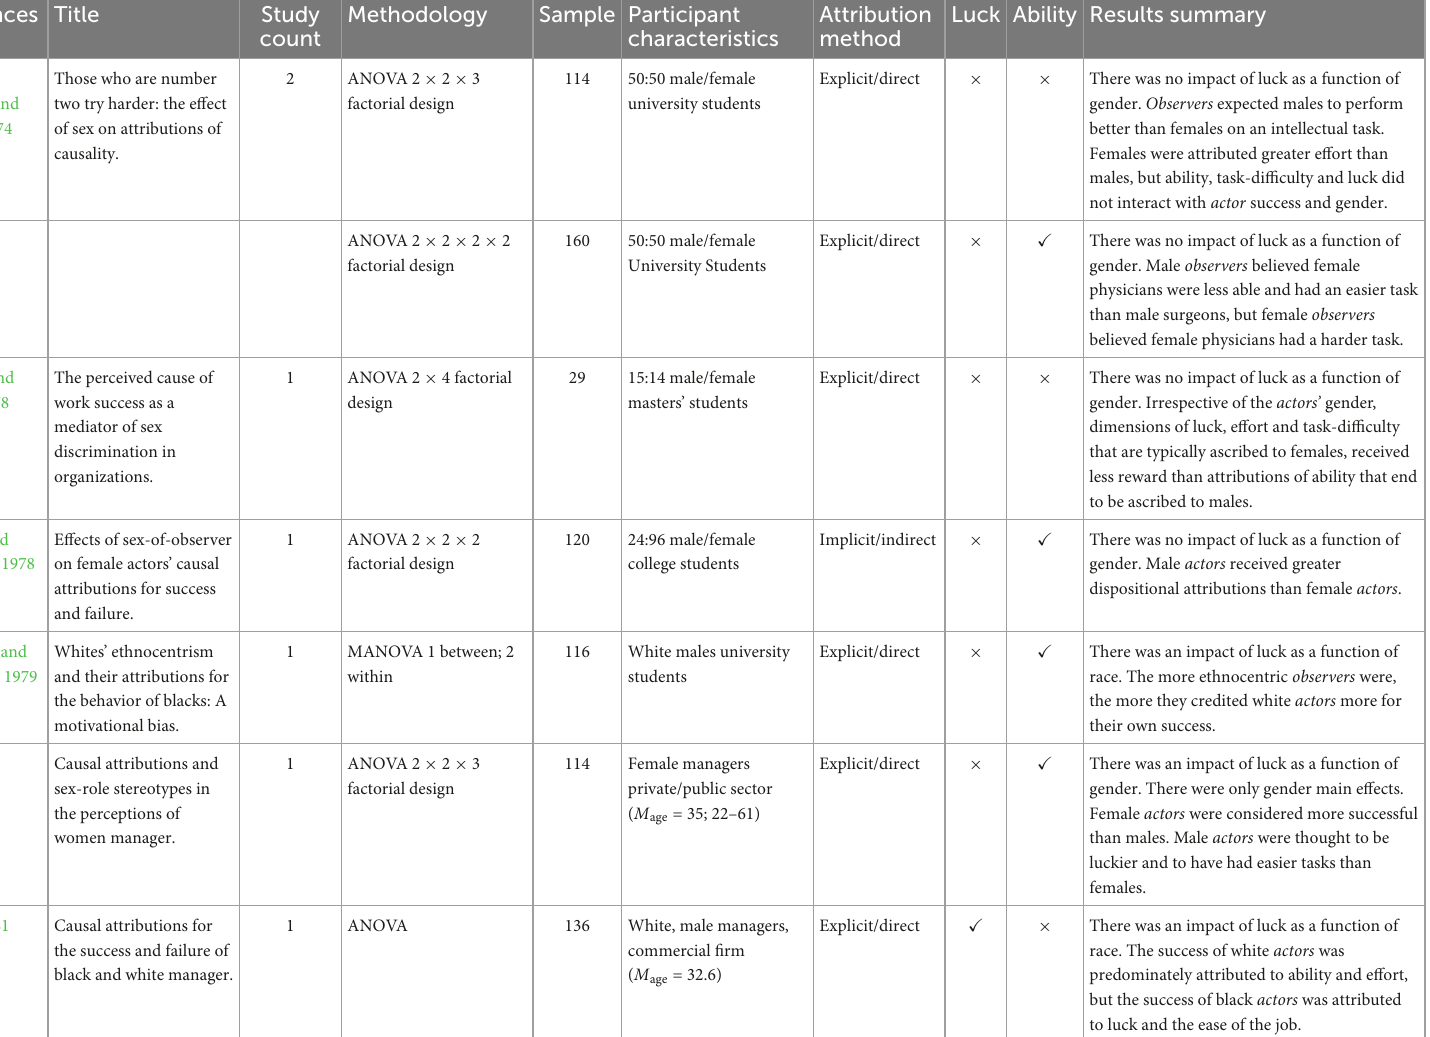
TABLE 1 Summary of review articles with sample characteristics ( N =